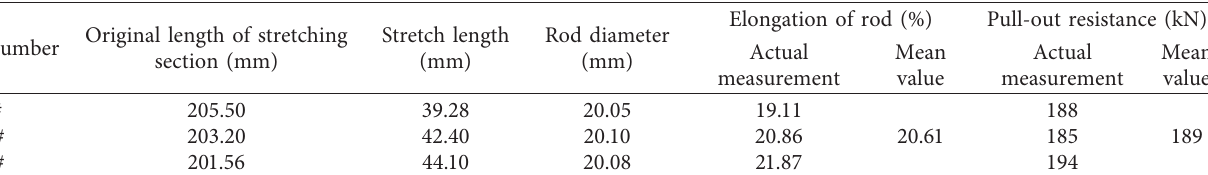
Figure 6: Drawing process of bolt body. (a) Rod body installation. (b) Broken rod. (c) Failure mode of the rod. Table 1: Drawing test results of deformed steel bars.